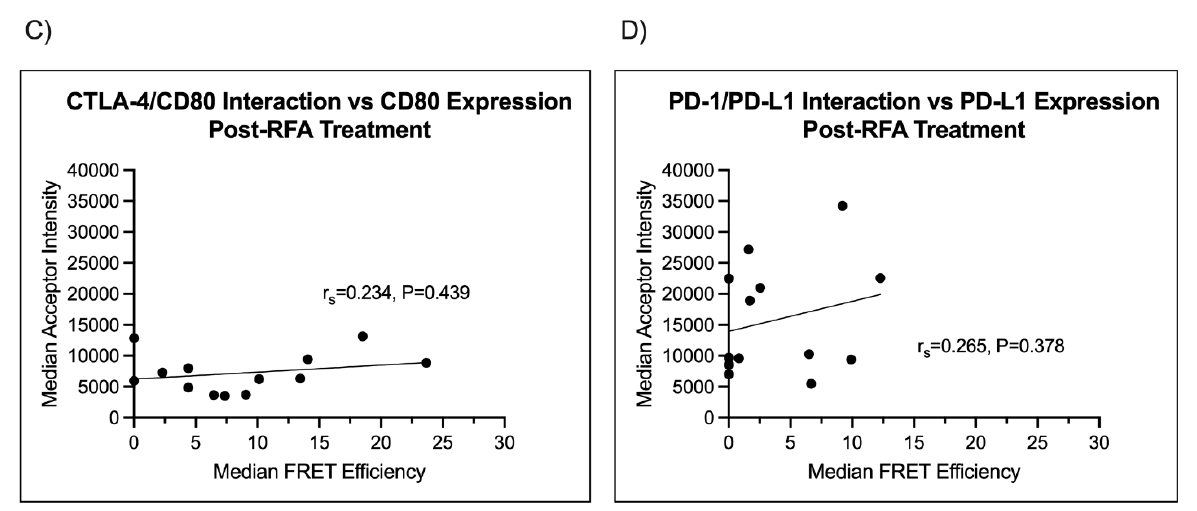
Figure 5. Checkpoint interaction does not correlate with ligand expression in pre- or post-RFA- treated lung metastases. The expression of each checkpoint ligand (CD80 or PD-L1) does not correlate with checkpoint interaction. ( A ) In lung metastases from lung 1, prior to RFA treatment, median CTLA-4/CD80 interaction states did not correlate with CD80 expression (r s = − 0.134, p = 0.632). ( B ) From the same lung, pre-RFA, PD-1/PD-L1 interaction states did not correlate with PD-L1 expression (r s = − 0.171, p = 0.541). ( C ) In patient samples taken from lung 2, post-RFA treatment of lung 1, checkpoint ligand expression failed to correlate with median CTLA-4/CD80 interaction (r s = 0.234, p = 0.439). ( D ) PD-1/PD-L1 interaction states failed to correlate with PD-L1 expression (r s = − 0.265, p = 0.378, respectively).